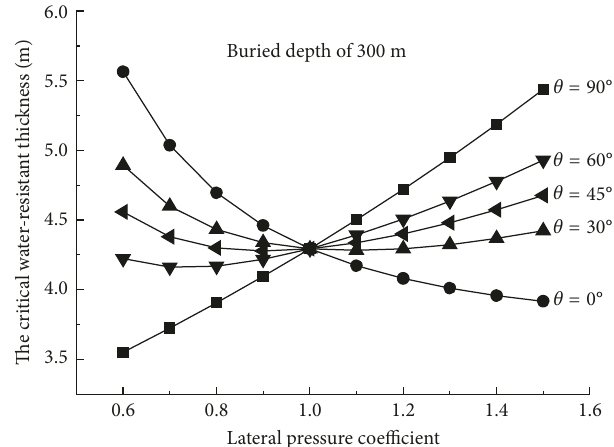
Figure 5: Relationship between the critical water-resistant thick- ness and lateral pressure coefficient.